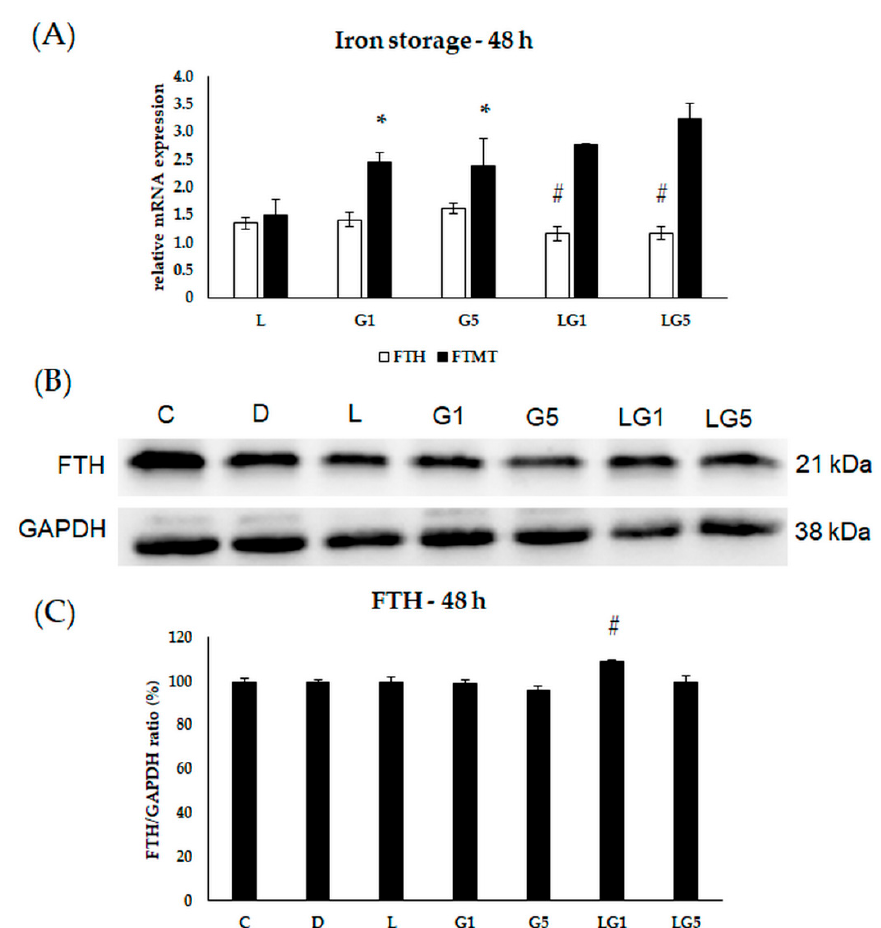
Figure 10. Determination of mRNA expression ( A ) and protein ( B , C ) levels of iron storing FTH and FTMT after lutein and Glu treatments of the SH-SY5Y cells at 48 h. SH-SY5Y cells were treated with 10 ng/µL of lutein, 1 mM, 5 mM Glu, or lutein with Glu together to detect the changes in the expression of FTH and FTMT. The gene expression measurements were performed by SYBR Green RT-PCR protocol with β -actin as a housekeeping gene, the relative expression of controls was regarded as 1. The protein expression measurements were performed by semi-dry Western blotting using GAPDH as a loading control. The protein’s OD was expressed as a percentage of the target protein/GAPDH ratio. The bars represent the mean values (±standard deviation error bars, SD) of three independent experiments ( n = 3) performed in triplicate and are presented relative to their control cells. The * marks the statistical significance of Glu treatments compared to control, # signs the statistical significance of combined (lutein with Glu) treatments compared to the Glu treatments at 48 h ( p < 0.05).